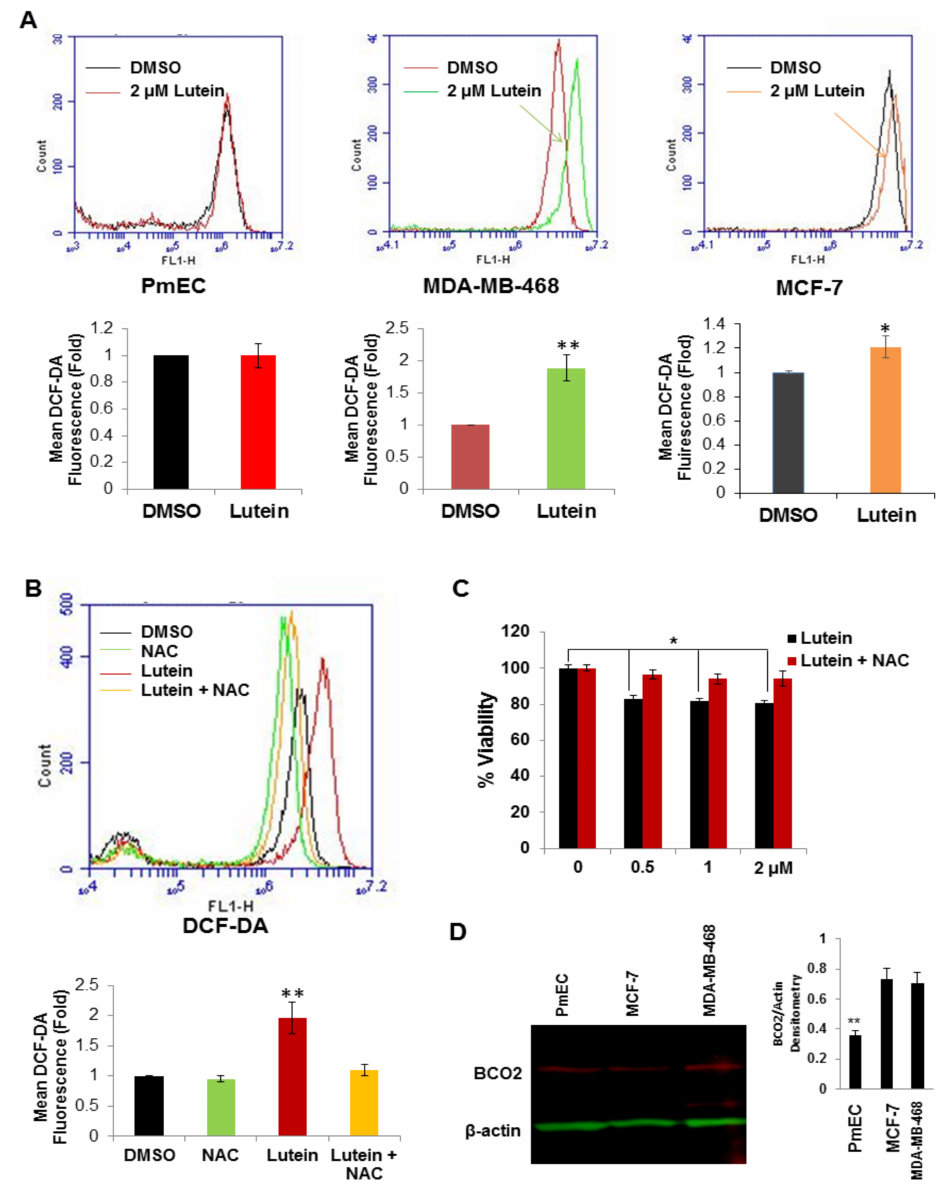
Figure 4. Effect of lutein on intracellular ROS production in human normal and breast cancer cells. ( A ) PmECs, MDA-MB-468 and MCF-7 cells were treated with 2.0 µ M lutein for 3 h and intracellular ROS levels were measured by flow cytometry. Data are presented as means ± S.D. and are representative of three independent experiments. * p < 0.05, ** p < 0.001, compared with control group. ( B ) MDA-MB-468 cells were pretreated with or without 3.0 mM NAC for 1 h, and followed by 2.0 µ M lutein for 3 h. Lutein induced an increase in ROS levels which is abolished by NAC. Data are presented as means ± S.D. and are representative of three independent experiments. ** p < 0.01, compared with the indicated group. ( C ) NAC blocked the growth inhibitory effect of lutein on breast cancer cells. MDA-MB-468 cells were grown in 96-well plates, and pre-treated with or without 3.0 mM NAC for 1 h, followed by lutein (0.5–2.0 µ M) or DMSO (control) for 48 h. Cell viability was measured by MTT assay. The experiments were performed in triplicate. Data are presented as mean ± S.D and are representative of three independent experiments; * p < 0.05). ( D ) Effect of lutein on expression of BCO2. PmEC, MCF-7 and MDA-MB-468 cells were gown in 6-well plate for 48 h. Cell lysates were prepared and subjected to Western blotting for BCO2. The histogram in Figure 4D indicates the average of adjusted BCO2 levels (mean ± SD, n = 3), ** p <